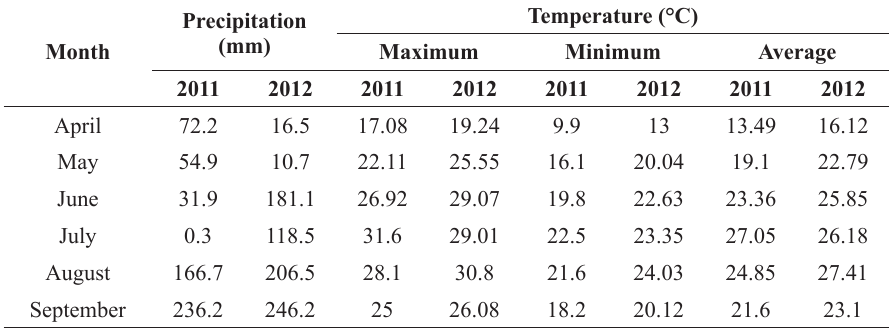
Monthly precipitation and temperature from April to September in 2011 and 2012 for experimental